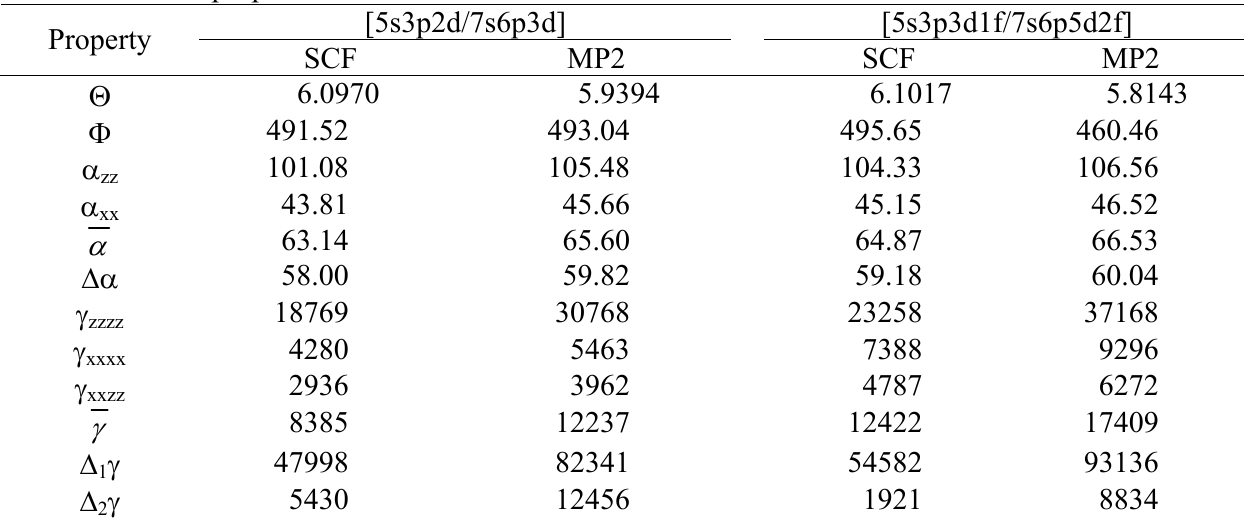
Table 3. Electric properties of BrCCBr a